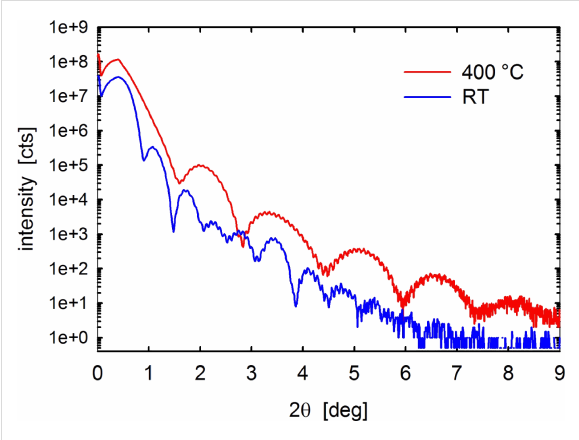
Figure 2: XRR pattern of MoS 2 thin films ( ≈ 10 nm) deposited at RT and 400 °C. X-ray wavelength λ = 0.1518 nm.